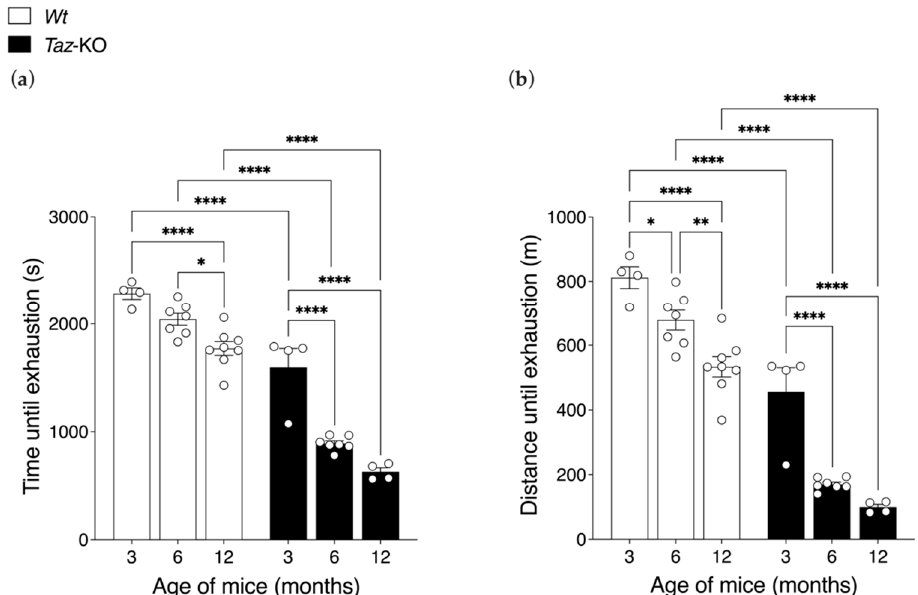
Figure 8. Declining exercise capacity in Taz -KO mice with age. Three separate age cohorts of mice ran on the treadmill until exhaustion, at which point the maximal running time ( a ) and distance ran ( b ) were recorded. Data are means ± SEM ( n = 4–8). Statistical analysis was performed using two-way ANOVA followed by Bonferroni’s multiple comparisons tests. * p < 0.05, ** p < 0.01, **** p < 0.0001.